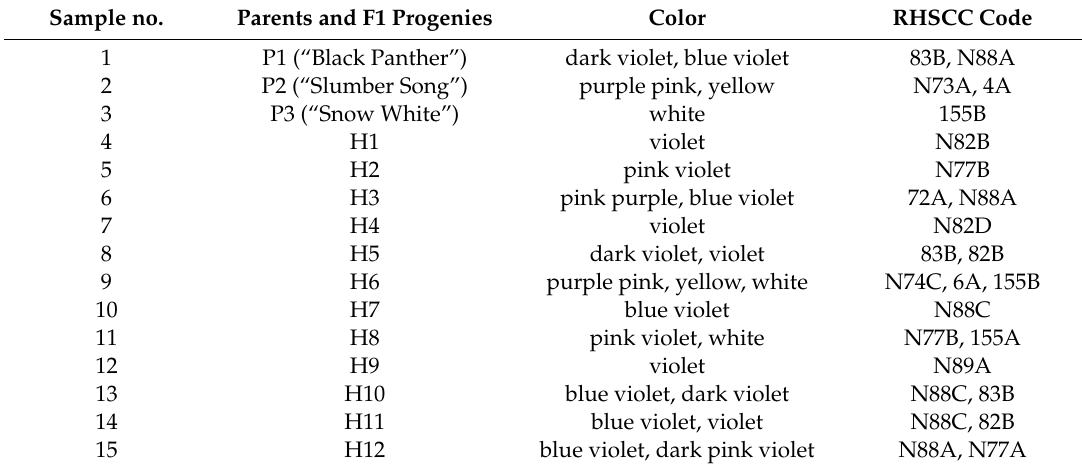
Table 1. Colors and Royal Horticultural Society Color Chart (RHSCC) code of genitors and F1 progenies selected for sequence-related amplified polymorphism (SRAP) and Fourier-transform infrared (FT-IR)